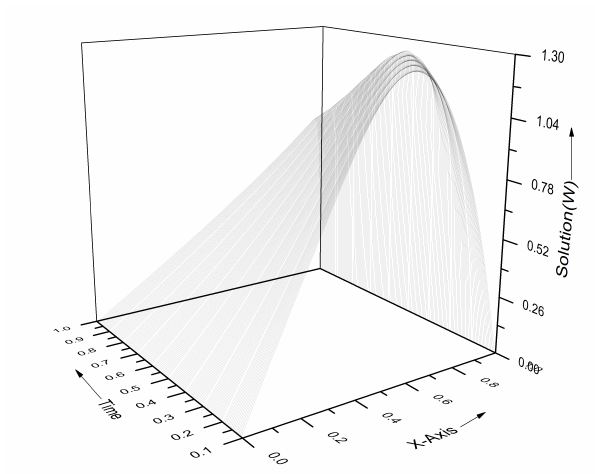
Figure 10. Three-dimensional (3D) representation of numerical results for problem 5.2 for ν d = 0.01, τ = 0.001, ∆ x = 0.0125 and at different times.